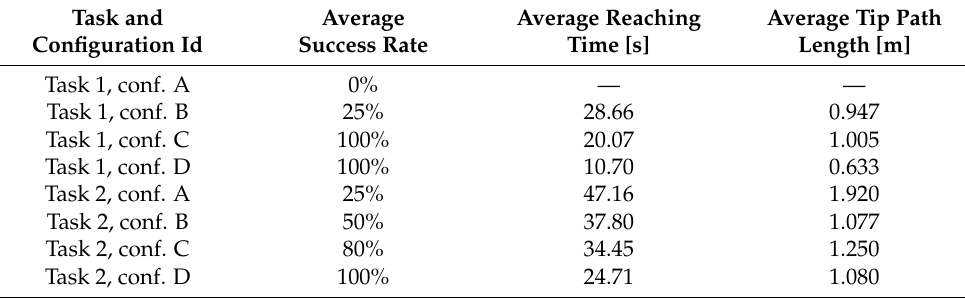
Table 2. Table with metrics of performance of different tasks with different configurations. Task